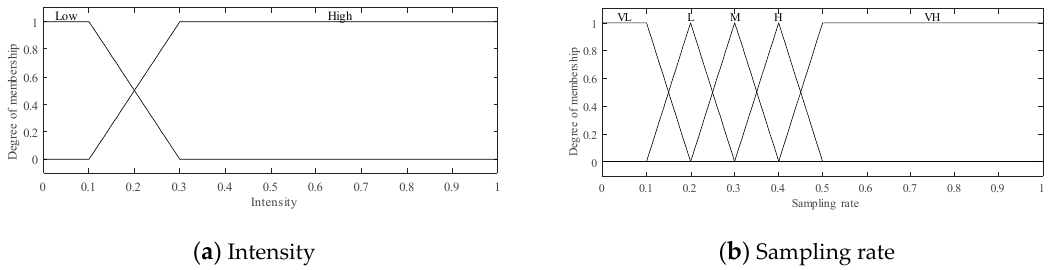
Figure 6. The two fuzzy input variables; (VL = Very Low, L = Low, M = Medium, H = High, VH = Very High).